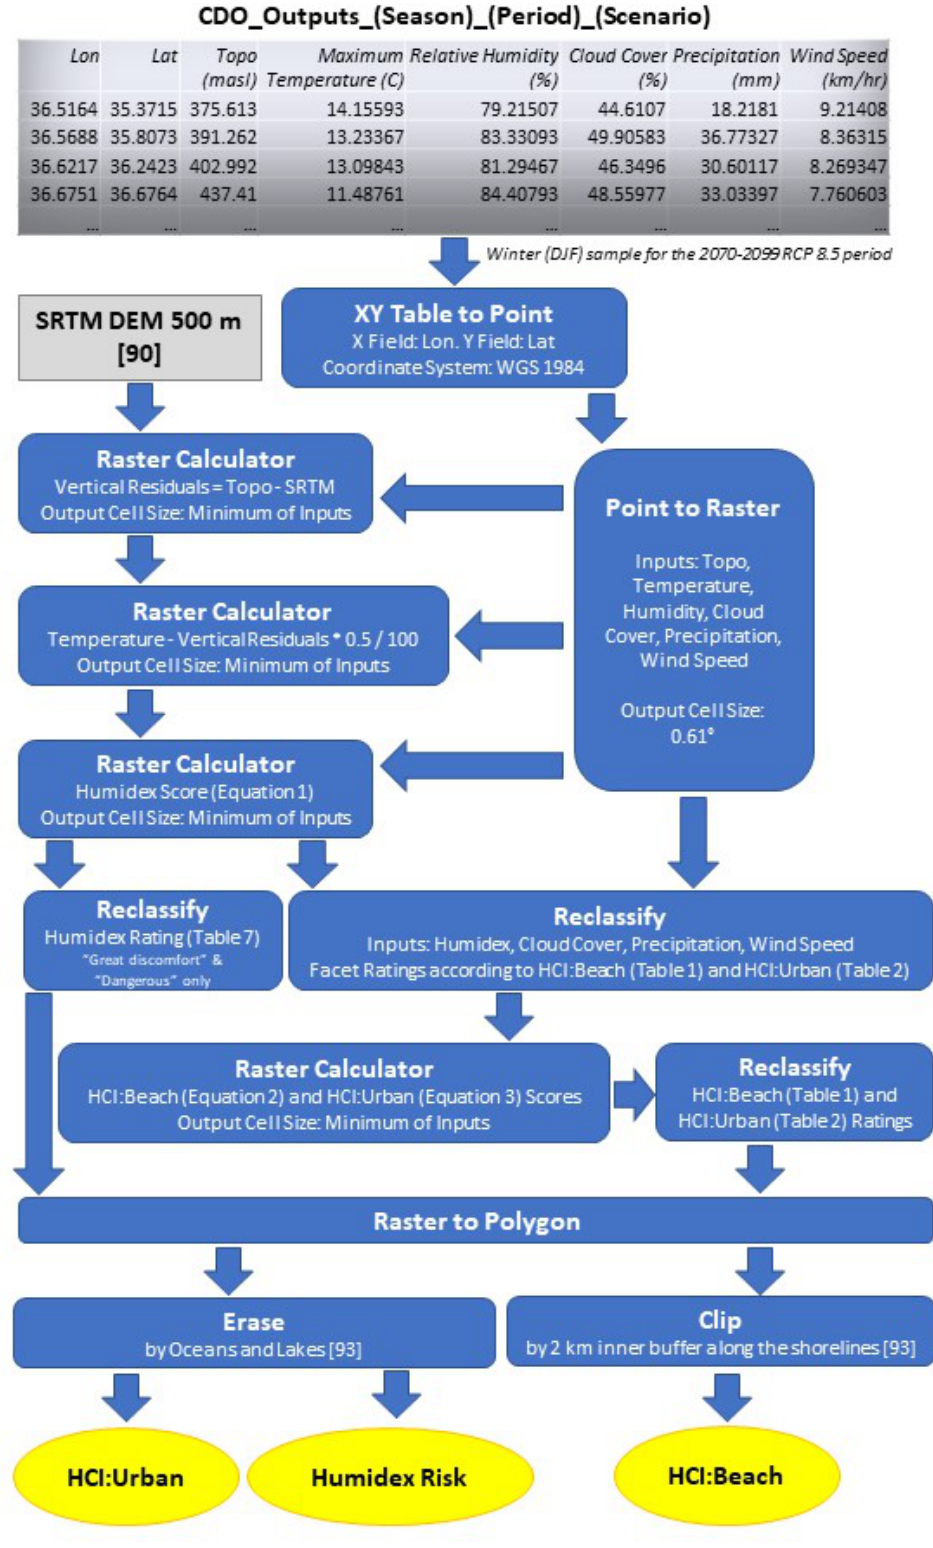
Figure 2. Stages of the Batch Geoprocessing Model Workflow on CDO Outputs for the HCI Variables. The model is iterated for each dataset representing different seasonal averages, periods and